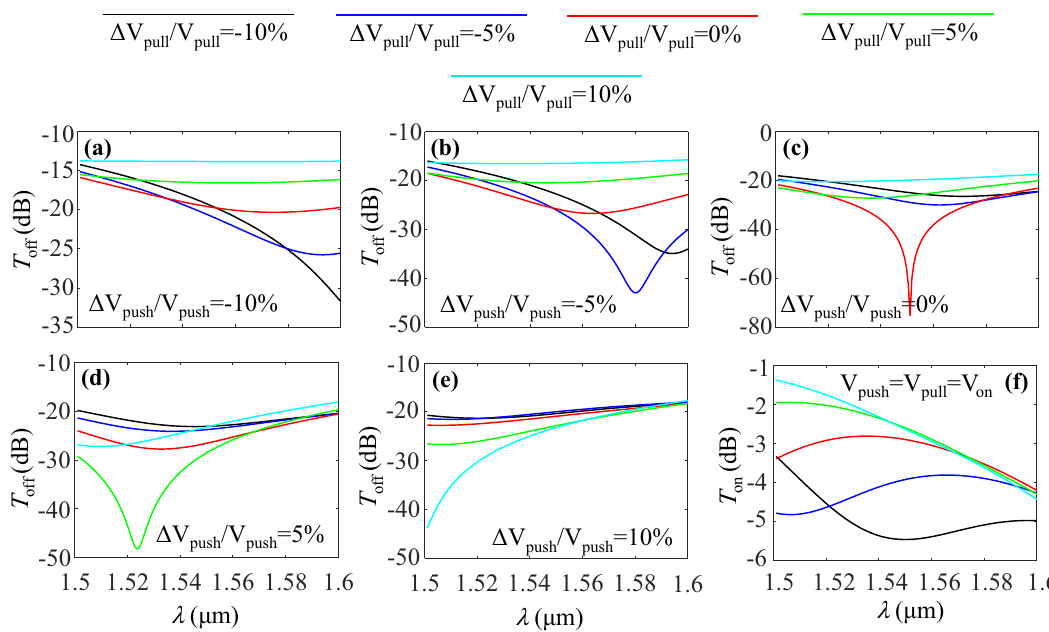
Figure 9. ( a ) Variations of the transmission spectra of the modulator in the off state for various pull voltage errors and at push voltage errors of ( a ) − 10%, ( b ) − 5%, ( c ) 0, ( d ) 5% and ( e ) 10%. ( f ) Transmission spectra of the modulator in the on state for various voltage errors.